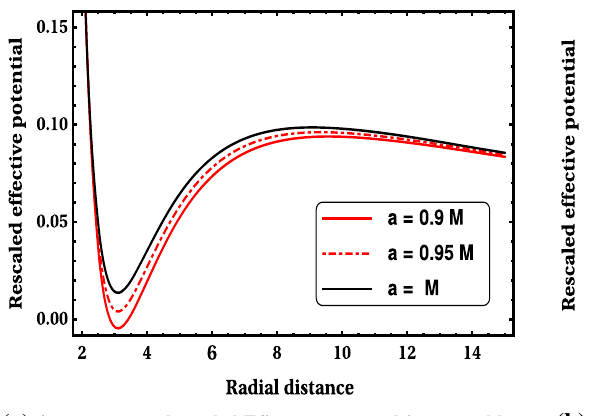
Fig. 2 The effective potential ( V eff ), rescaled using ( r 2 + l 2 ) − 2 , is pre- sented in the above figure for marginally bound orbits (i.e., ˜ E = 1) and various choicesofangularmomentumoftheblackhole.Wediscusstwo particular cases of interest, one is ˜ L = 3 . 6 M and another corresponds